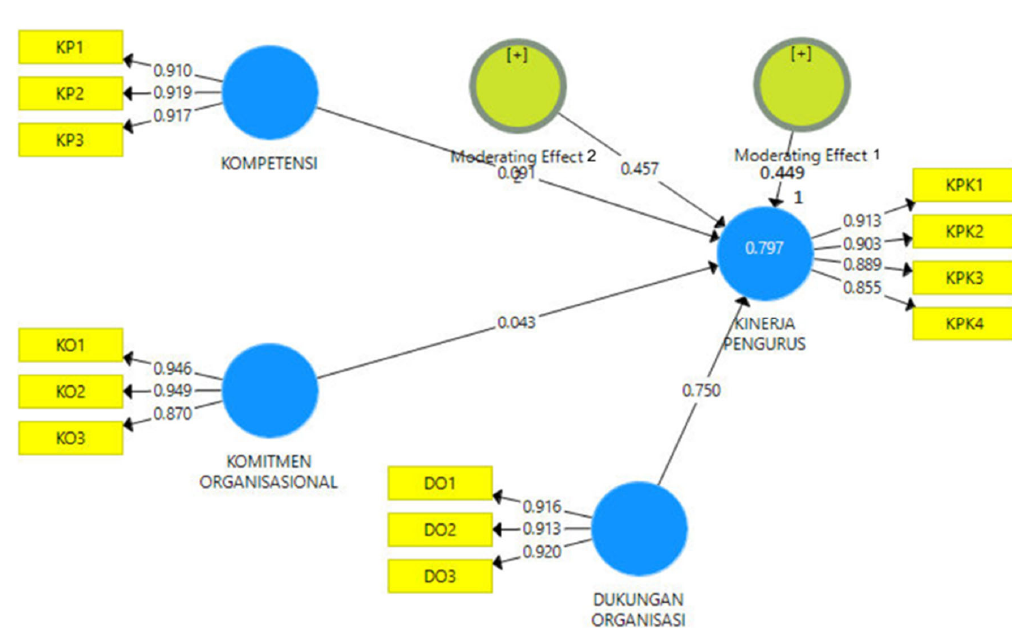
Fig. 2. The Study’s Path Model Sources: SmarPLS 3.3